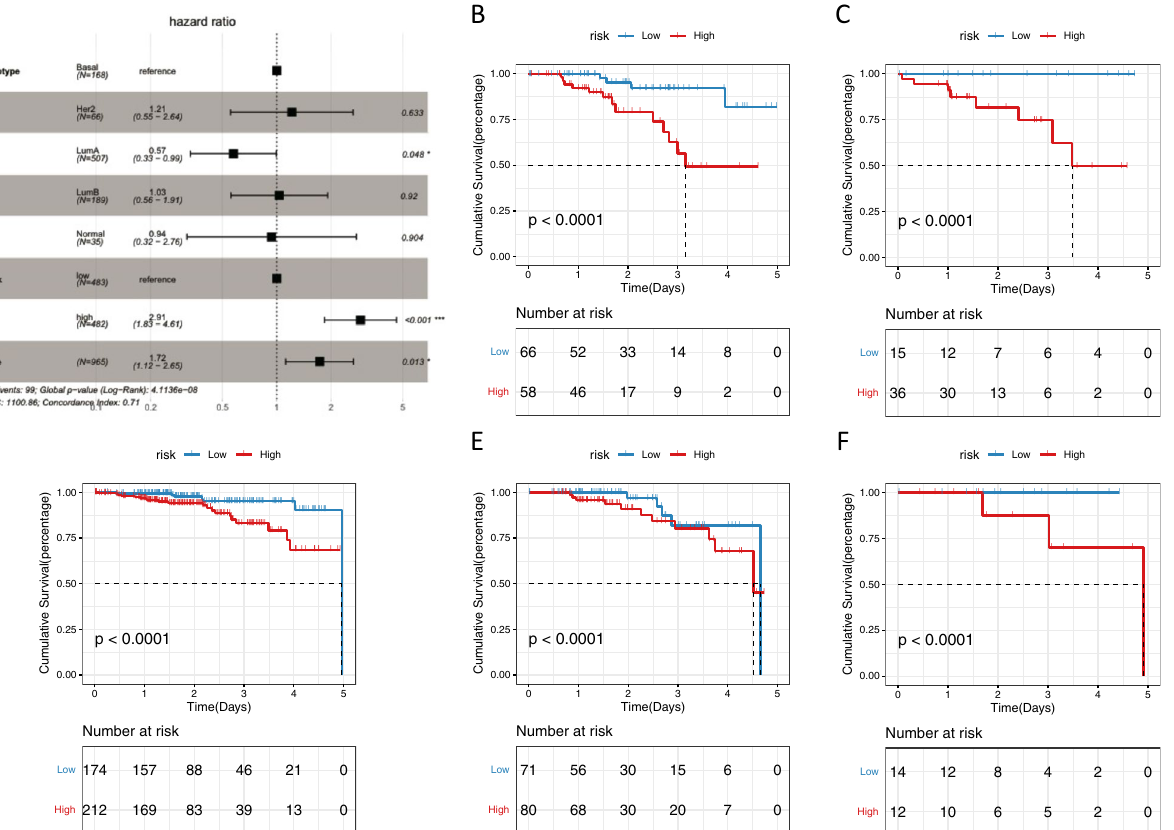
Figure 7. Efficiency evaluation of multivariate analysis and risk scoring. ( A ) The results of the multivariate analysis are displayed by forest map. ( B – F ) Cumulative survival of different molecular subtypes of breast cancer. ( B : Basal-like, C : Her2-enriched, D : Luminal A, E : Luminal B, F :